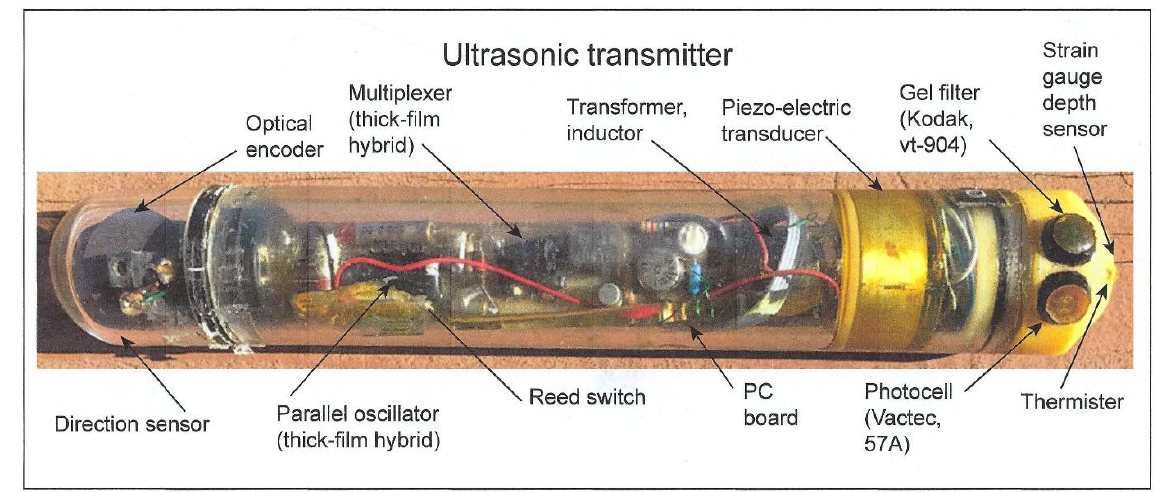
Figure 8. Ultrasonic transmitter with two irradiance sensors. The upper sensor is blue-green from the 47A gel filter to simulate scotopic vision; the bottom sensor is the VT 904 photosensor without the 49A filter used to simulate photopic vision.